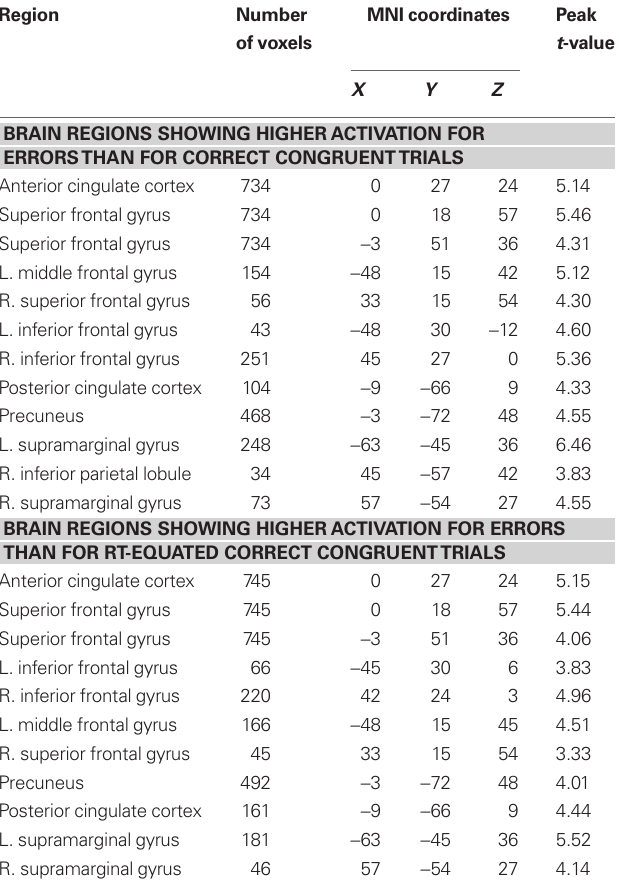
Table 3 | Differences in brain activity between errors and correct incongruent trials before and after controlling for conditional differences in mean RT.